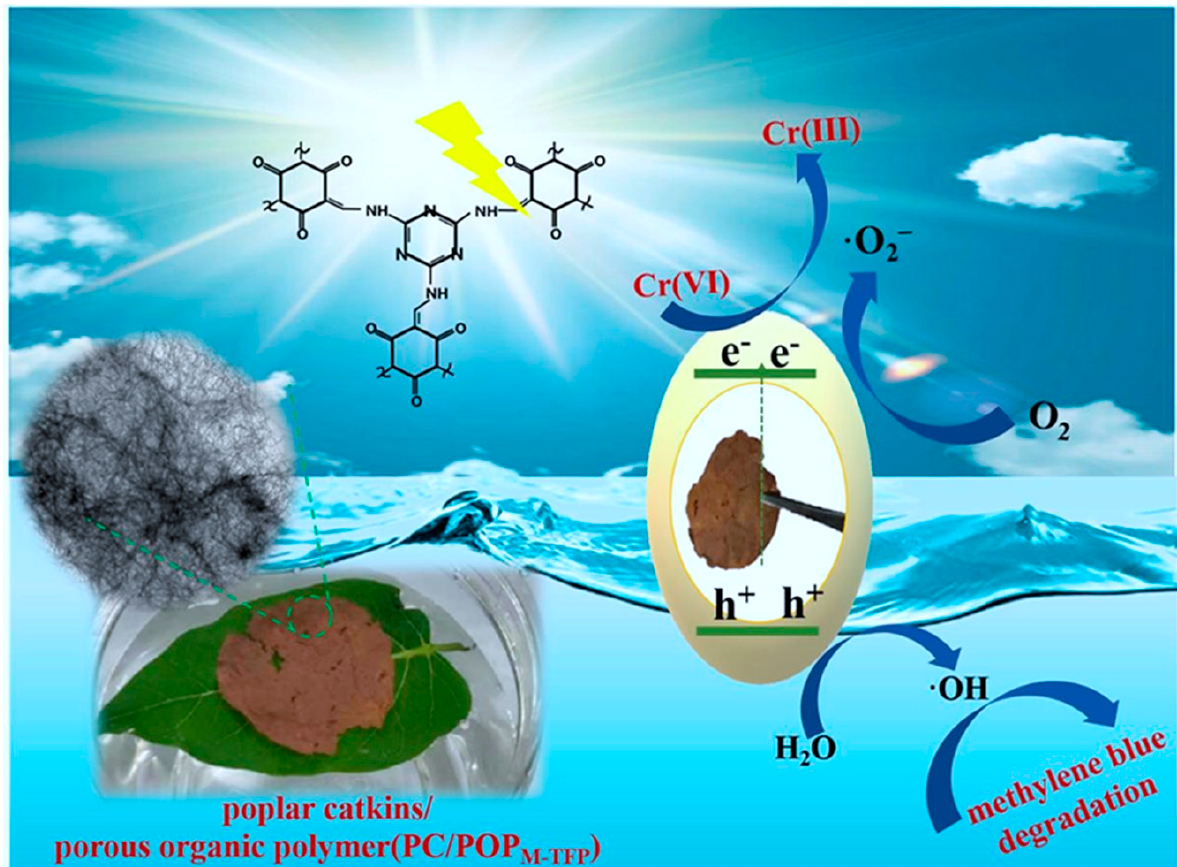
Figure 5. Scheme of floating triazine–based porous organic polymer (POP) photocatalyst grown on poplar catkins and used for water multipurpose water decontamination [100].